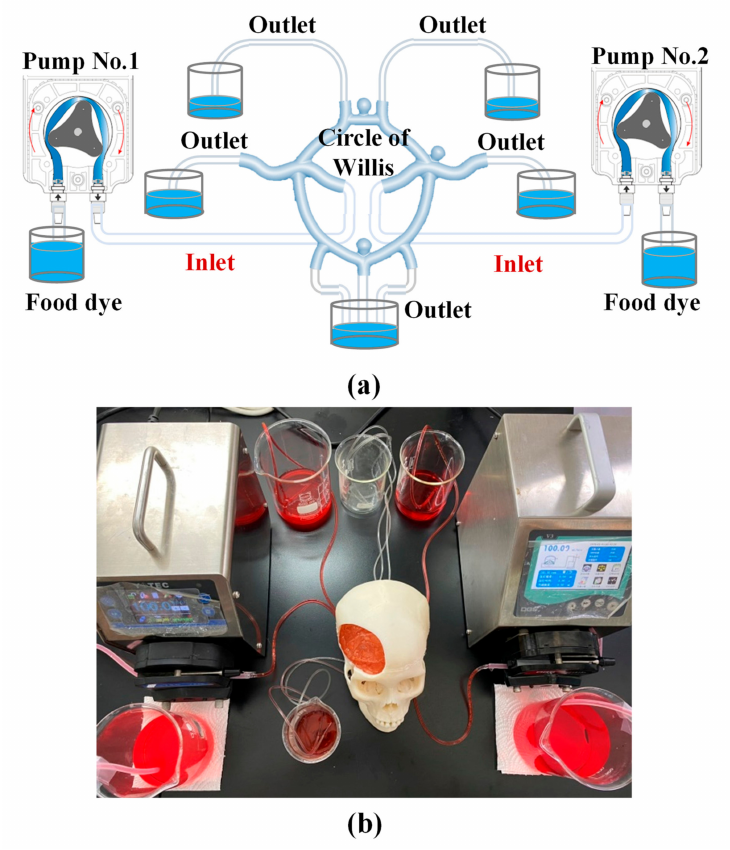
Figure 5. ( a ) The circulatory system, which included two pumps and several beakers; ( b ) the overall system specifically for practicing the clipping of aneurysms during